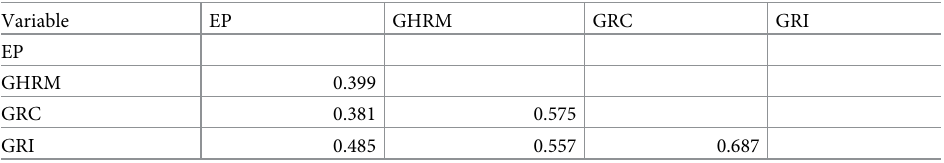
Table 4. Heterotrait–monotrait ratio (HTMT) for first-order.